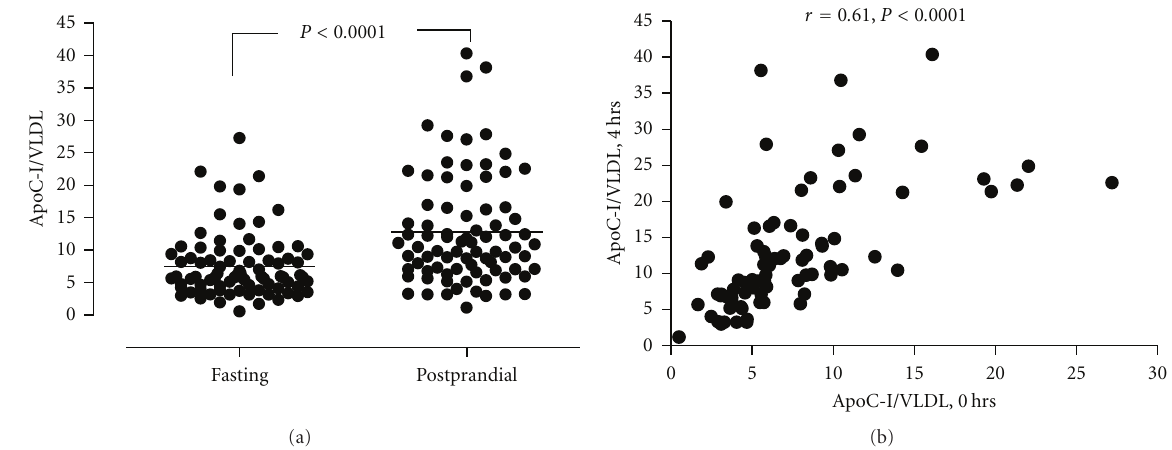
Figure 2: Dot plots showing the number of apoC-I per VLDL particle for each participant under fasting and postprandial conditions (a), and the relation between the number of apoC-I per VLDL particle under fasting and postprandial conditions (b).